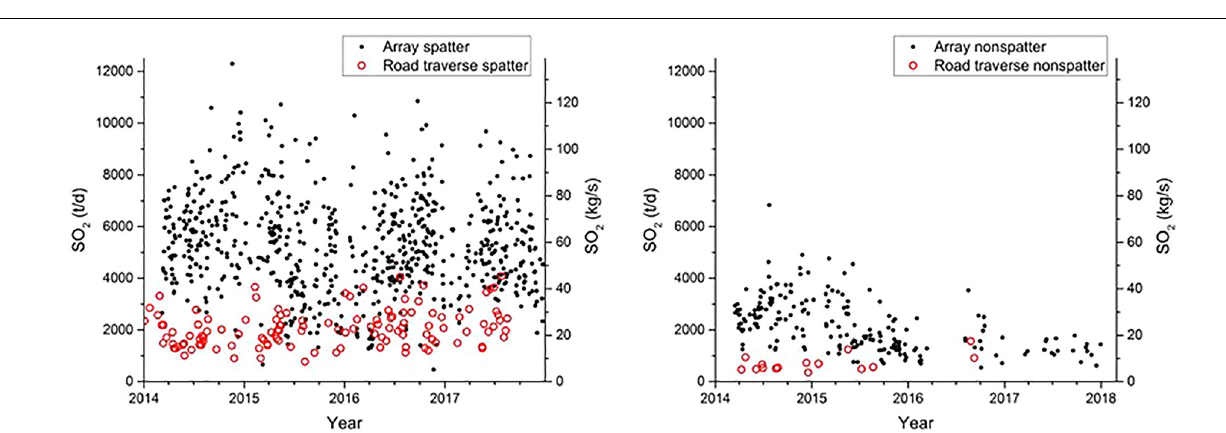
FIGURE 12 | Emission rates from FLYSPEC array (black dots) and road traverses (red circles) separated into spattering (Left) and non-spattering (Right) lava lake conditions. On average, the road-based method returns emission rates that are about 60% less than those calculated from the FLYSPEC array for both lava lake conditions. Non-spattering episodes are defined by RSAM level < 100